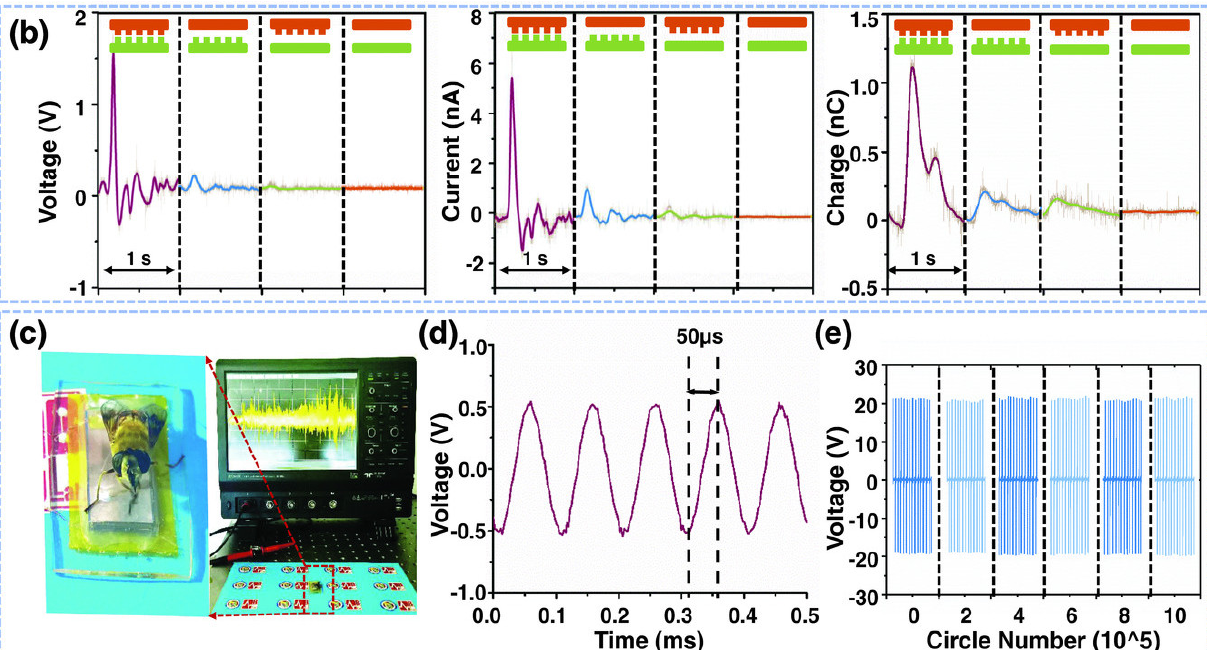
Figure 20. Electrical output performance of the SUPS with four different surface structures of the triboelectric films [111]. ( a ) Results of the output voltage, current, and transferred charge of SUPS when a lineal motor applied a compressive force of 50 N over four distinct structural configurations of triboelectric films. ( b ) Results of the output voltage, current, and transferred charge of SUPS placed on the radial artery and considering four different structural configurations of triboelectric films. ( c ) Real-time output voltage of SUPS caused by the oscillations (frequency close to 200 Hz) of the wings of a honeybee. ( d ) Output voltage of SUPS due to mechanical vibrations signals (10 kHz) generated by a loudspeaker. ( e ) Stability tests of the open-circuit voltage of SUPS during one million operating cycles. For this test, external forces of 30 N were applied on SUPS using a linear motor. Reprinted with permission from [111]. Copyright 2017, WILEY-VCH Verlag GMbH & Co. KGaA, Weinheim.